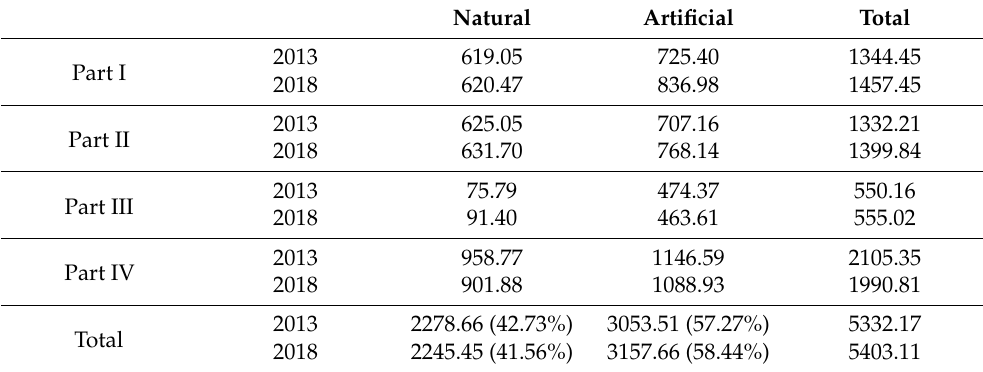
Table 3. Coastline length (km) of the Yangtze River